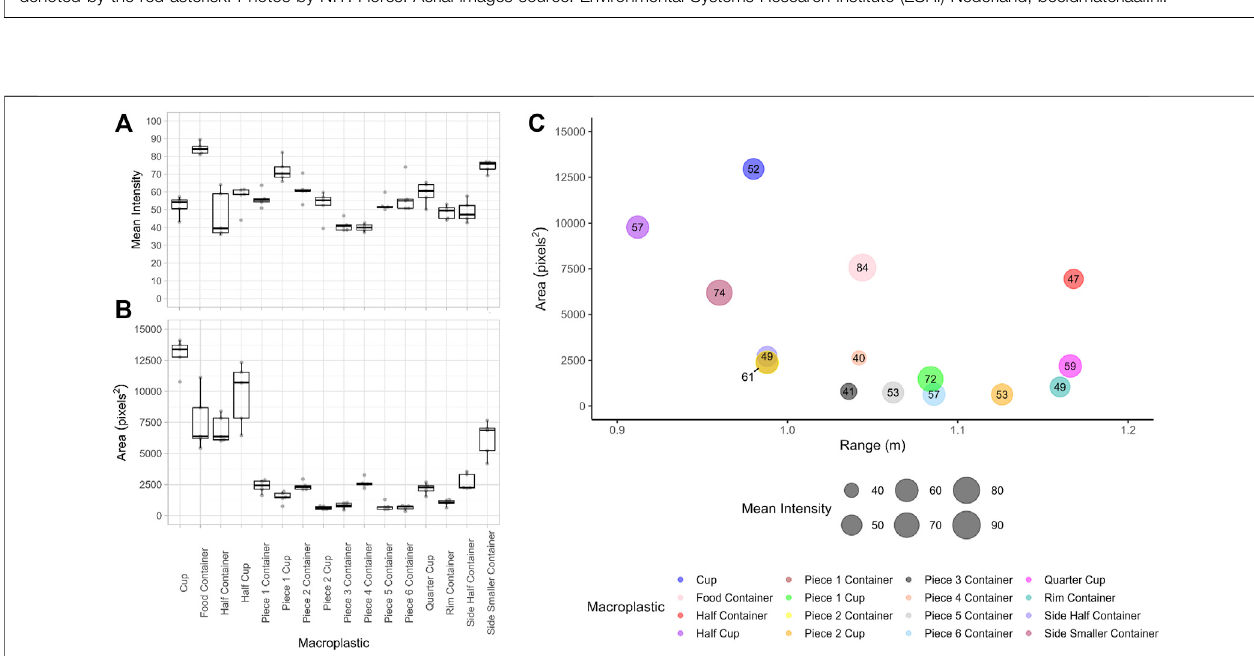
FIGURE 3 | Box plots of (A) the mean intensity and (B) the area of the macroplastic re fl ections ( n = 5) from the ARIS sonar images as detected in standing water. Thecenterlinesrepresentthemedianvalues,theedgesoftheboxesthe fi rstandthirdquartiles,thewhiskerstheminimumandmaximum,andtheunderlyingdatapoints appear ingrey. (C) Uniquemeanre fl ectionsforeachtype ofmacroplastic givenbythemeanarea(y-axis) andmeanintensity(bubble sizes/values)atmeanrange(x-axis) for the ARIS sonar images as detected in standing water.